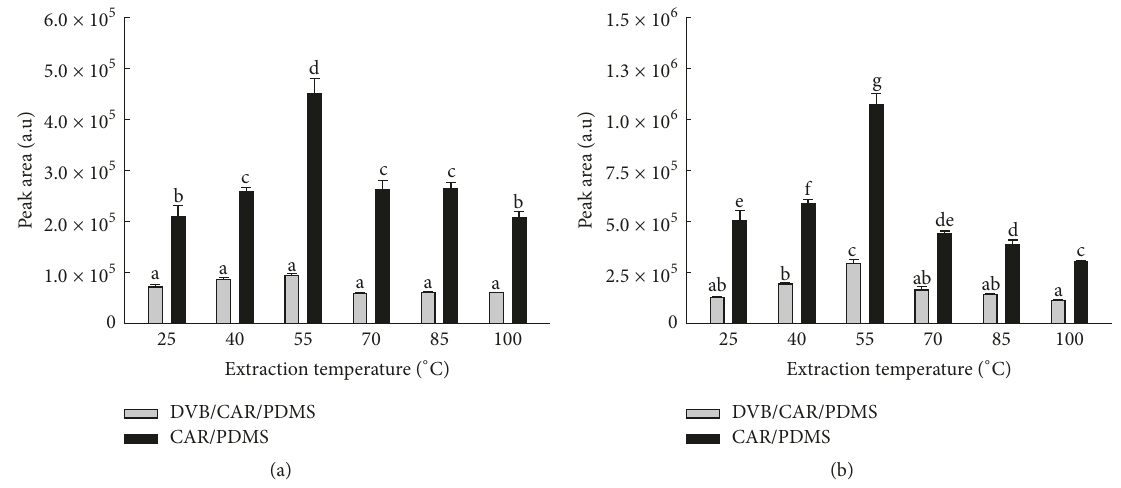
Figure 2: Comparison of DVB/CAR/PDMS and CAR/PDMS fibers on the extraction efficiencies of 2-propenal from corn (a) and soybean (b) oils at different temperatures (25–100 ∘ C). Different letters indicate the significant differences at 𝑝 <